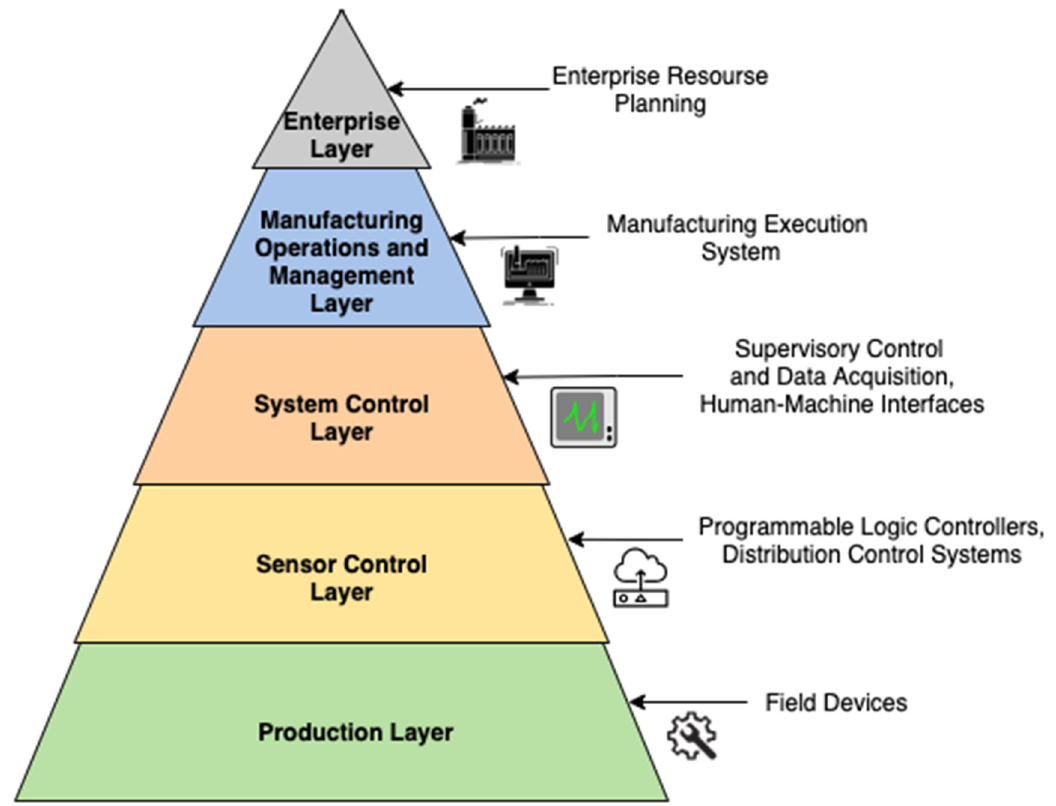
Figure 1. Top-down approach to manufacturing system according to ISA-95 Automation Pyramid.